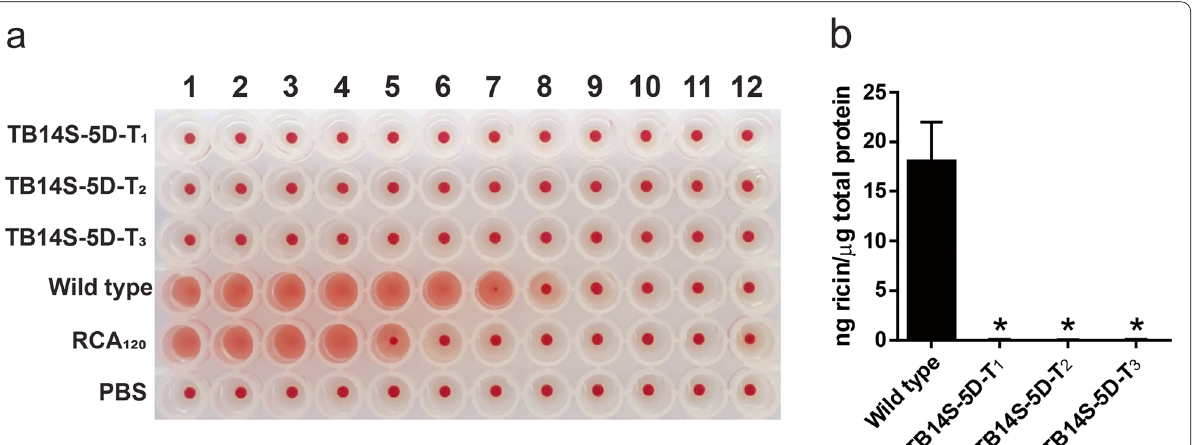
Fig. 3 Ricin/RCA 120 proteins are not detected in seeds from three generations of transgenic bio-detoxified event TB14S-5D. a Proteins from transgenic [TB14S-5D, generations T 1 , T 2 , and T 3 (homozygous)] and non-transgenic (wild type) seeds were tested for their capacity to hemagglutinate red blood cells (2% suspension). Protein concentration was serially diluted by a ratio of ½ from rows 1 to 12, starting with 2 μg total protein/μL. RCA 120 (starting with 0.1 μg/μL) was used as a positive control and PBS was a negative control. Agglutinated RBC formed a diffuse mat, whereas non-agglutinated RBC sediment formed a dot at the bottom of the well. b ELISA was used to detect and quantify ricin in the endosperm. Ricin was detected in non-transgenic seeds (wild type seeds) and could not be detected in positive transgenic seeds from generations T 1 , T 2 , and T 3 . Asterisks represent significant differences compared to control ( P < 0.01, n